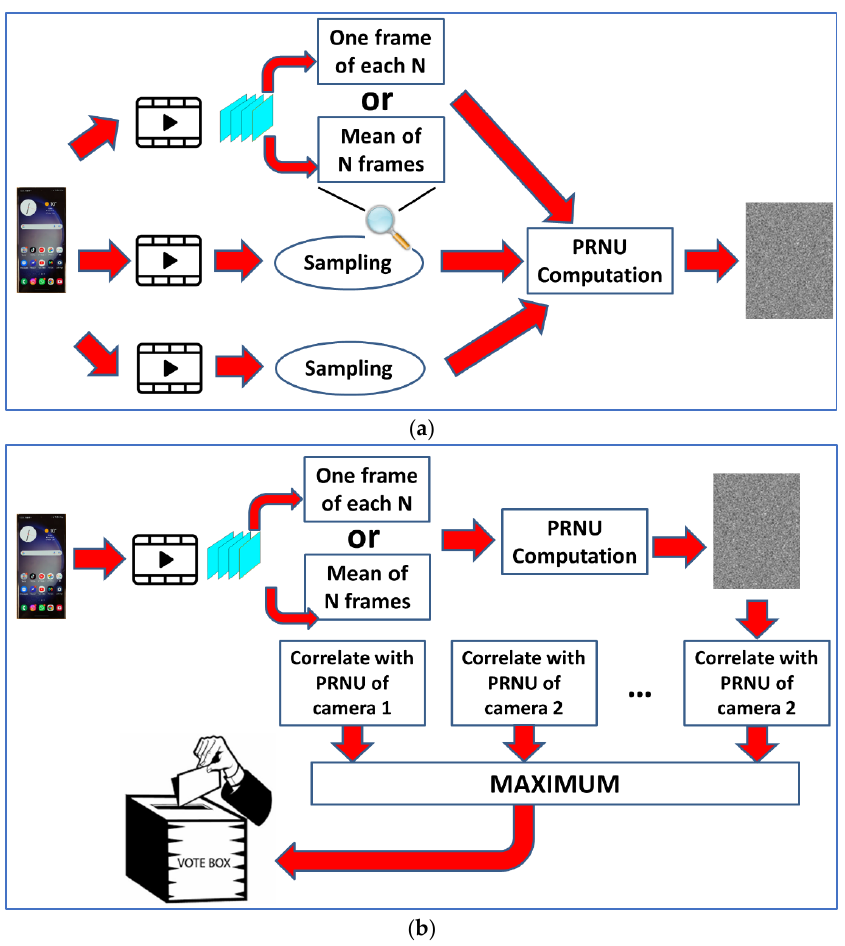
Figure 3. SCI for videos: ( a ) characterization (training); ( b ) recognition. Table 1. SCI on video, test material. VISION dataset (smartphone videos); method: majority, N = 15. Average in the Training Phase Average in the Running